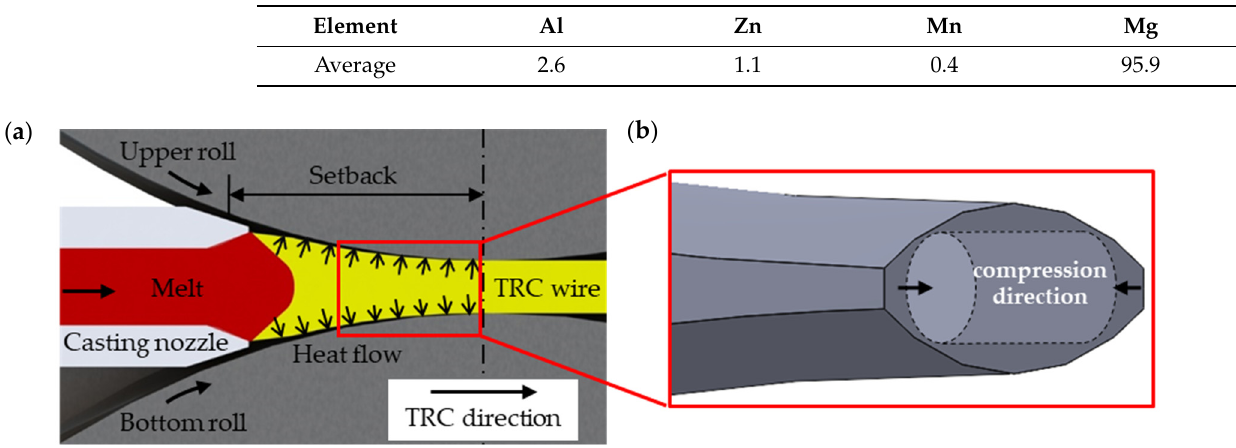
Table 1. Chemical composition of the AZ31 ingots in wt.% [9].